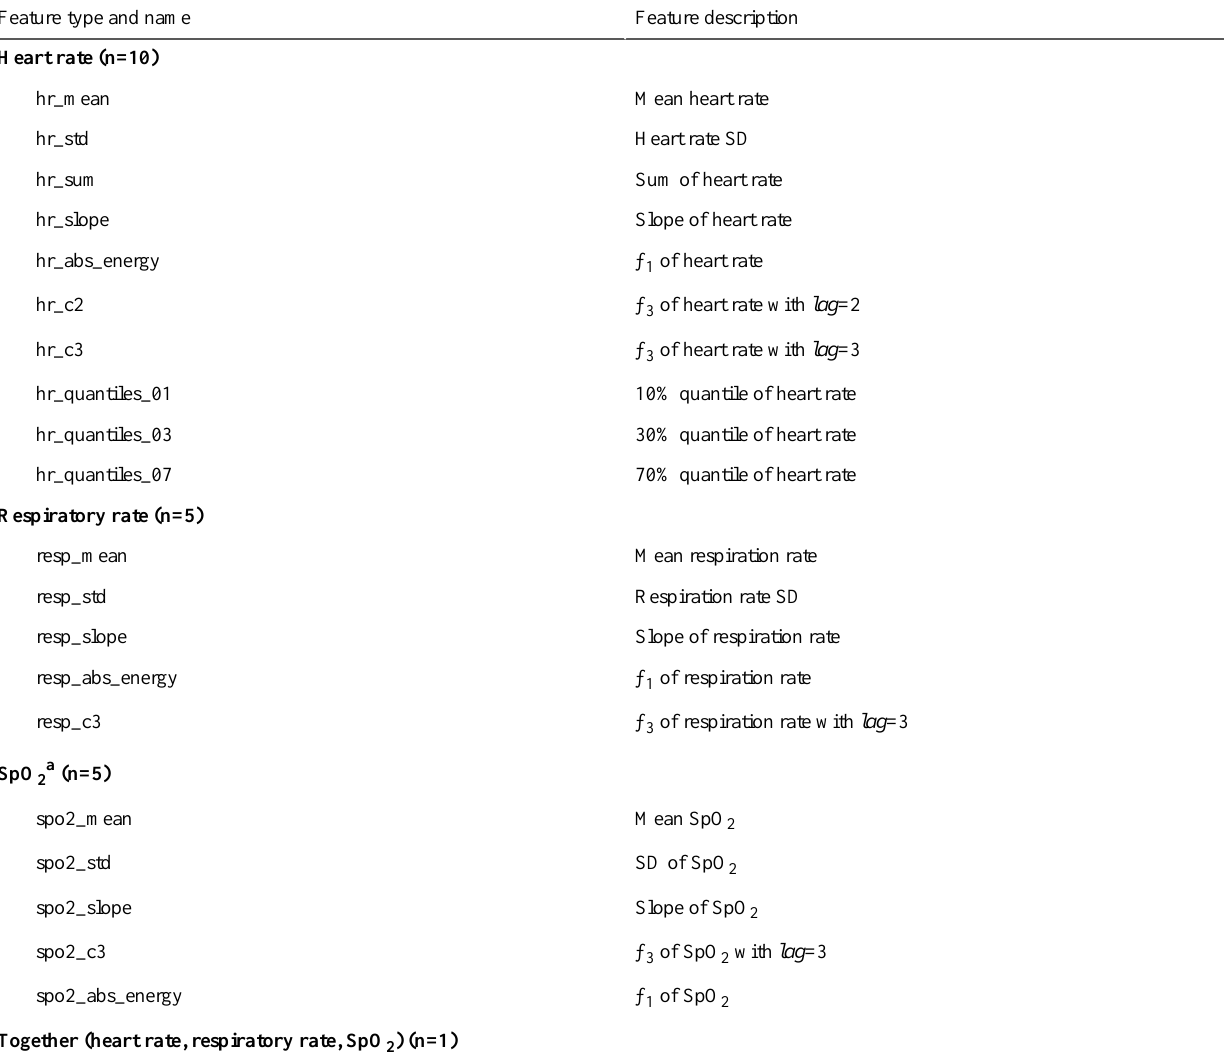
Feature descriptionFeature type and